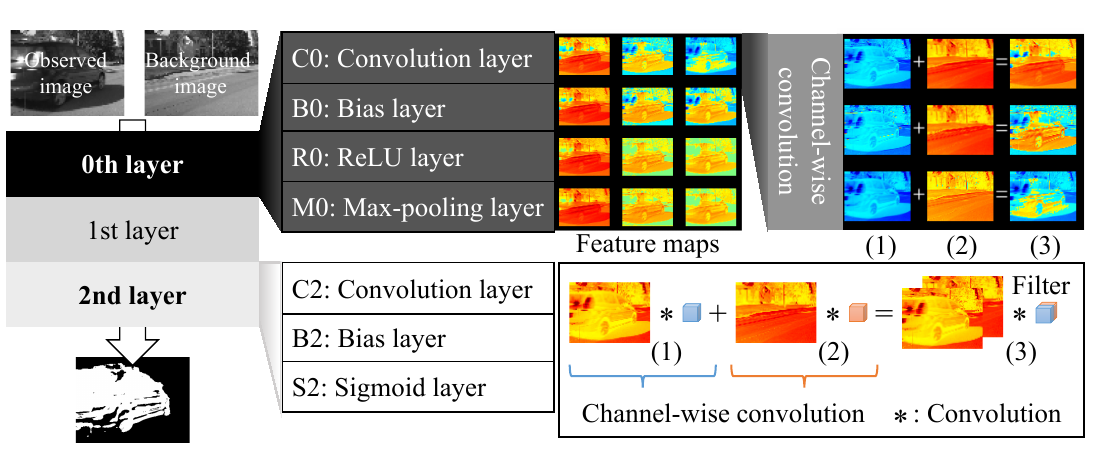
Figure 1. Visualization of feature maps in our modified network. All feature map resolutions in the network are the same as an input consisting of an observed image and a background image. Every layer contains three or four sub-layers (convolution layer, bias layer, activation layer and max-pooling layer). A bias layer adds biases to feature maps after the previous convolution layer convolves feature maps with filters. A rectified liner unit (ReLU) or a sigmoid function is used as an activation function in the activation layer after the previous bias layer. A stride is one in all max-pooling layers. In addition, we analyze operations in convolution layers through channel-wise convolutions (called as depth-wise convolutions in [31]). A convolutional operation can be decomposed into channel-wise convolutions and matrix additions. The channel-wise convolution helps us to understand filters through observation of feature maps. We introduce abbreviations to identify the sub-layers. The abbreviations represent types of sub-layers and a layer number with the sub-layer. For example, S2 denotes sigmoid layer in the 2nd